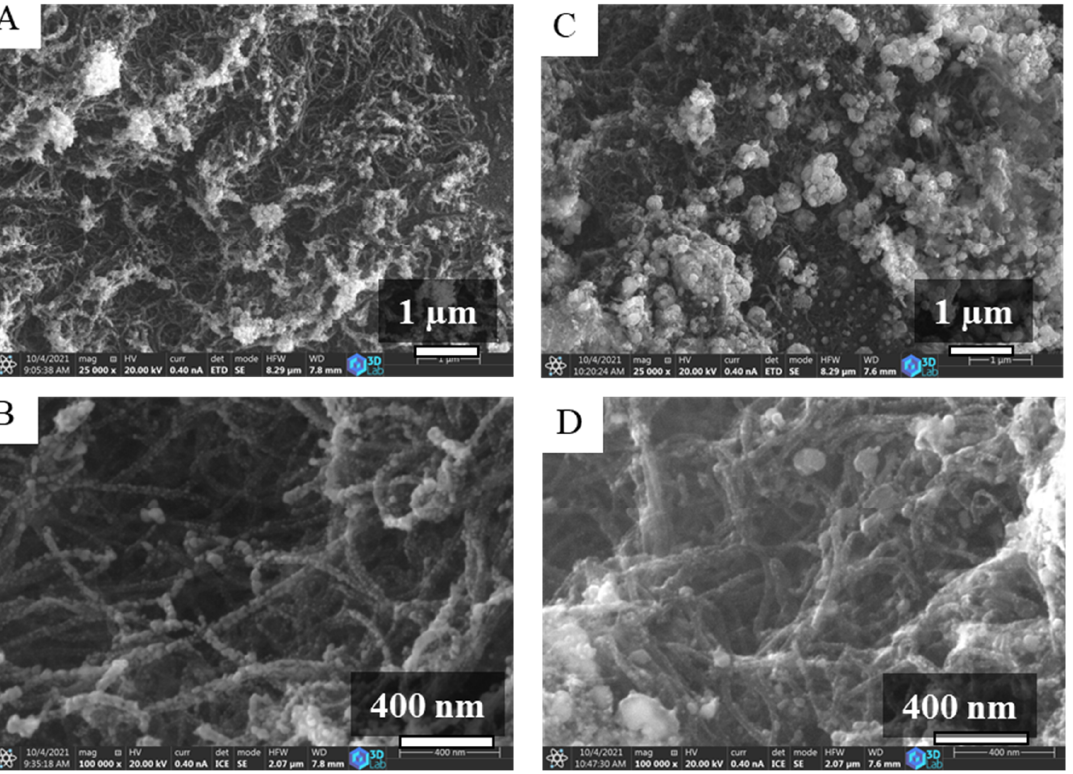
Figure 4. SEM images of the nickel ( A , B ) and magnetite ( C , D ) containing, palladium and platinum decorated granulated carbon nanocomposites (GCNC). Pd-Pt/Ni-GCNC—( A , B ) and Pd-Pt/Fe- GCNC ( C , D ).